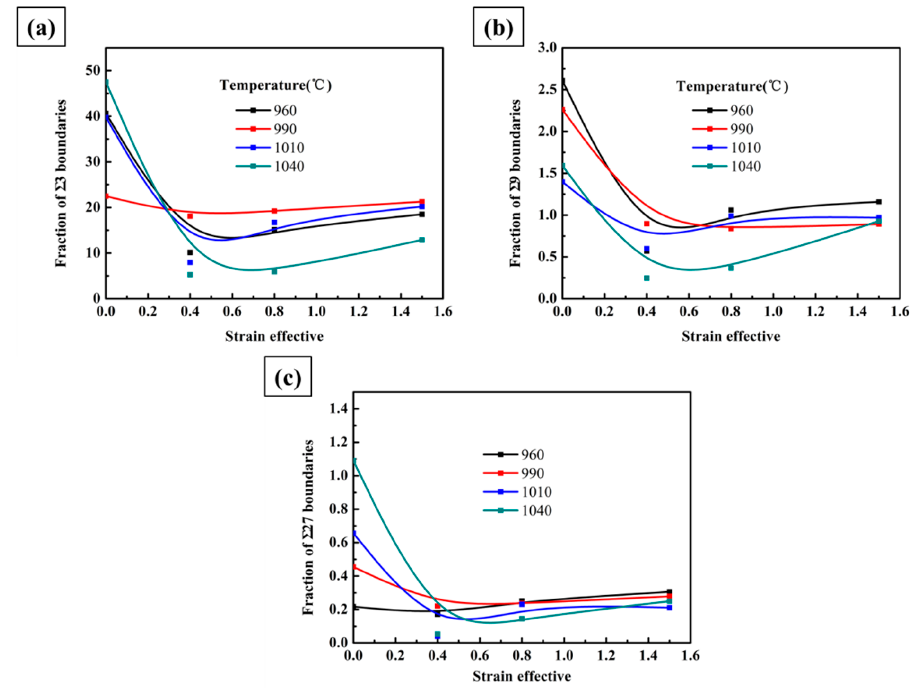
Figure14. Theevolutionoftwinboundaryfraction: ( a ) Σ 3boundary; ( b ) Σ 9boundary; ( c ) Σ Figure 14. The evolution of twin boundary fraction: ( a ) Σ 3 boundary; ( b ) Σ 9 boundary; ( c ) Σ 27 boundary.